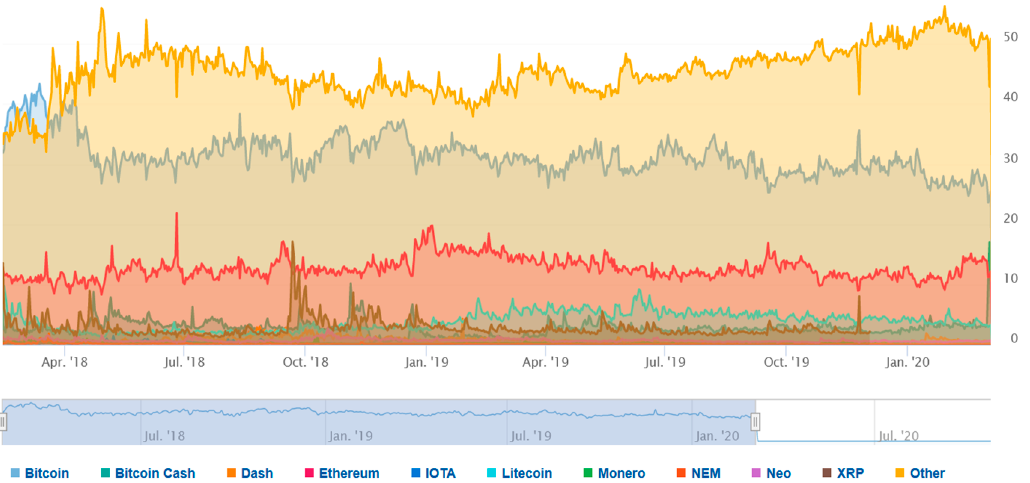
Figure 6. Structure of the daily turnover of the cryptocurrency market, billion USD. Source: https://ru.investing.com/crypto/charts.